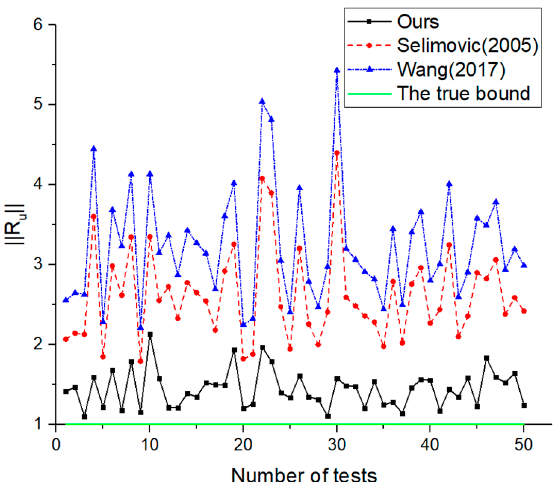
( ) R u of NURBS surfaces with ( ) u R u of NURBS surfaces with u